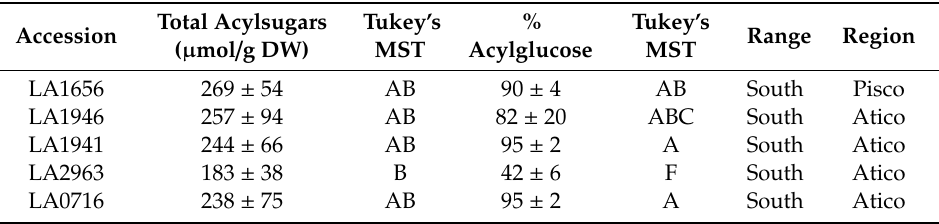
Figure 3. CID mass spectra of acylsugar structural isomers in positive-ion mode. ( A ) Mass spectra of S3:19(4,5,10)-1 (top) and S3:19(4,5,10)-2 (bottom). Structures of both compounds were resolved by NMR (Figure 4). ( B ) Mass spectra of S3:16(5,5,6) (top) and S3:16(4,4,8) (bottom). Structures of these compounds were not resolved by NMR, and the specific branching patterns and positions of acyl chains are unknown. 2.5. NMR Spectroscopy Resolves Structural Relationships between Acylsugars We selected 10 acylsugars for purification and structural resolution by NMR, including five triacylsucroses (S3:12(4,4,4), S3:18(4,4,10)-1, S3:18(4,4,10)-2, S3:19(4,5,10)-1, and S3:19(4,5,10)-2) and five triacylglucoses (G3:12(4,4,4), G3:18(4,4,10)-1, G3:18(4,4,10)-2, G3:19(4,5,10)-1, and G3:19(4,5,10)- 2) (Table 1; Figure 4; See Tables S6- S15, Figs. S3-62 for NMR chemical shifts and spectra). These compounds were selected due to the high abundance of the specified acylglucoses in S. pennellii LA0716 and structurally similar acylsucroses in S. pennellii LA0716 asff1-1 mutants. NMR spectroscopy confirmed that all examined disaccharide-containing acylsugars possess a sucrose core